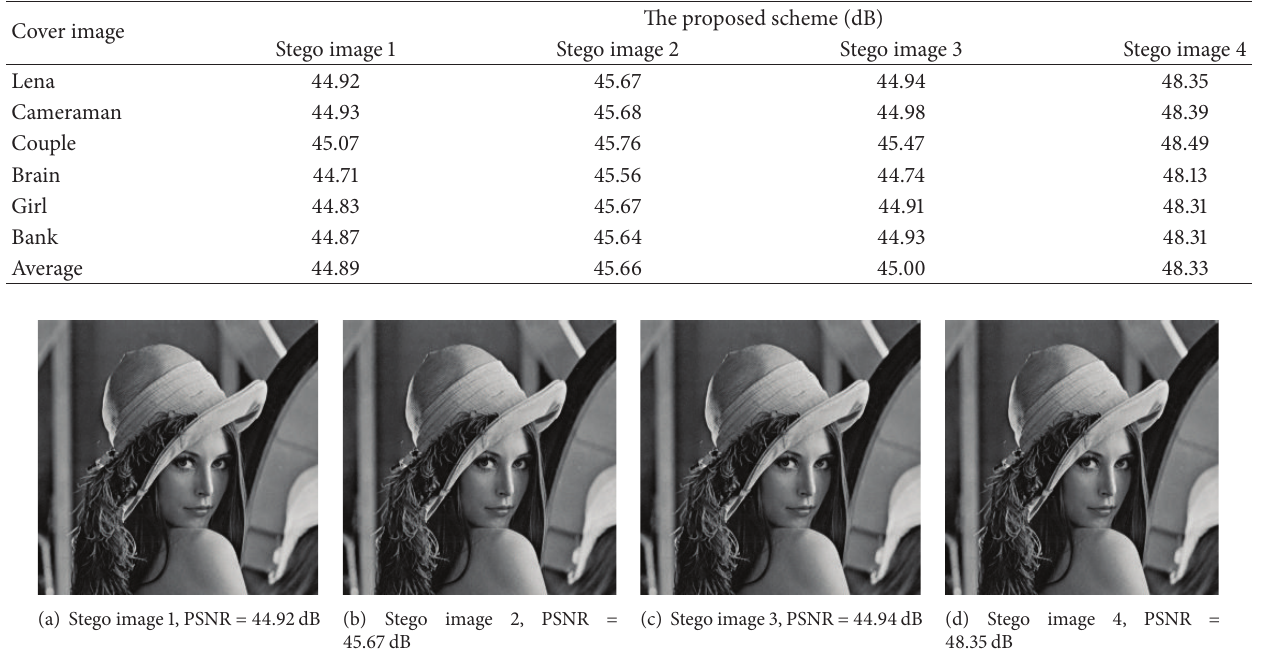
Figure 10: Stego images.